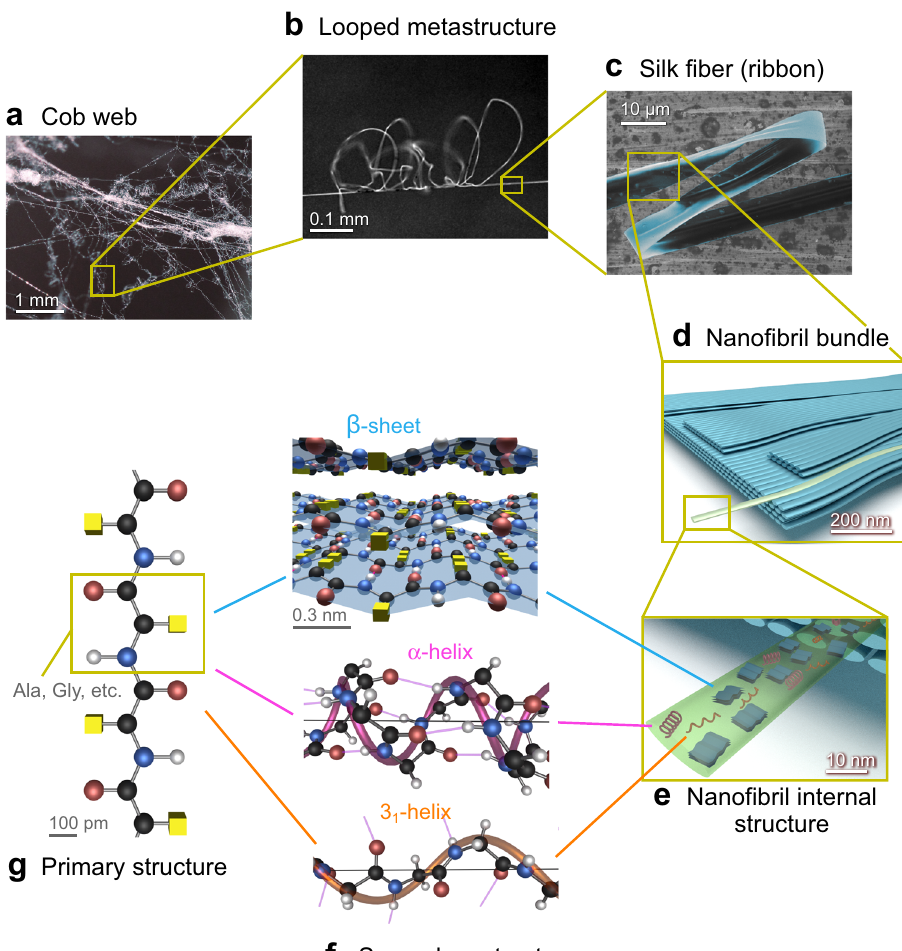
Fig. 6 Hierarchical structure of Loxosceles silk. a The recluse spider ’ s cob-web. b Looped metastructure made of Loxosceles silk ribbons. c Single ribbon (false-colored SEM, n = 5 independent SEM experiments). d Schematic of ribbon entirely composed of 20 nm thin nano fi brils. e β -sheets (blue), α - (pink) and 3 1 -helices (orange) within a single nano fi bril (schematic). f Ala- β -sheet, Gly-3 1 -helix, and α -helix segment in protein 2N3E 83 . Yellow cubes: functional groups on the C α atoms; transparent spirals: approximate helix structure. The color scheme used for different atoms are the same as Fig. 3. g Silk protein primary